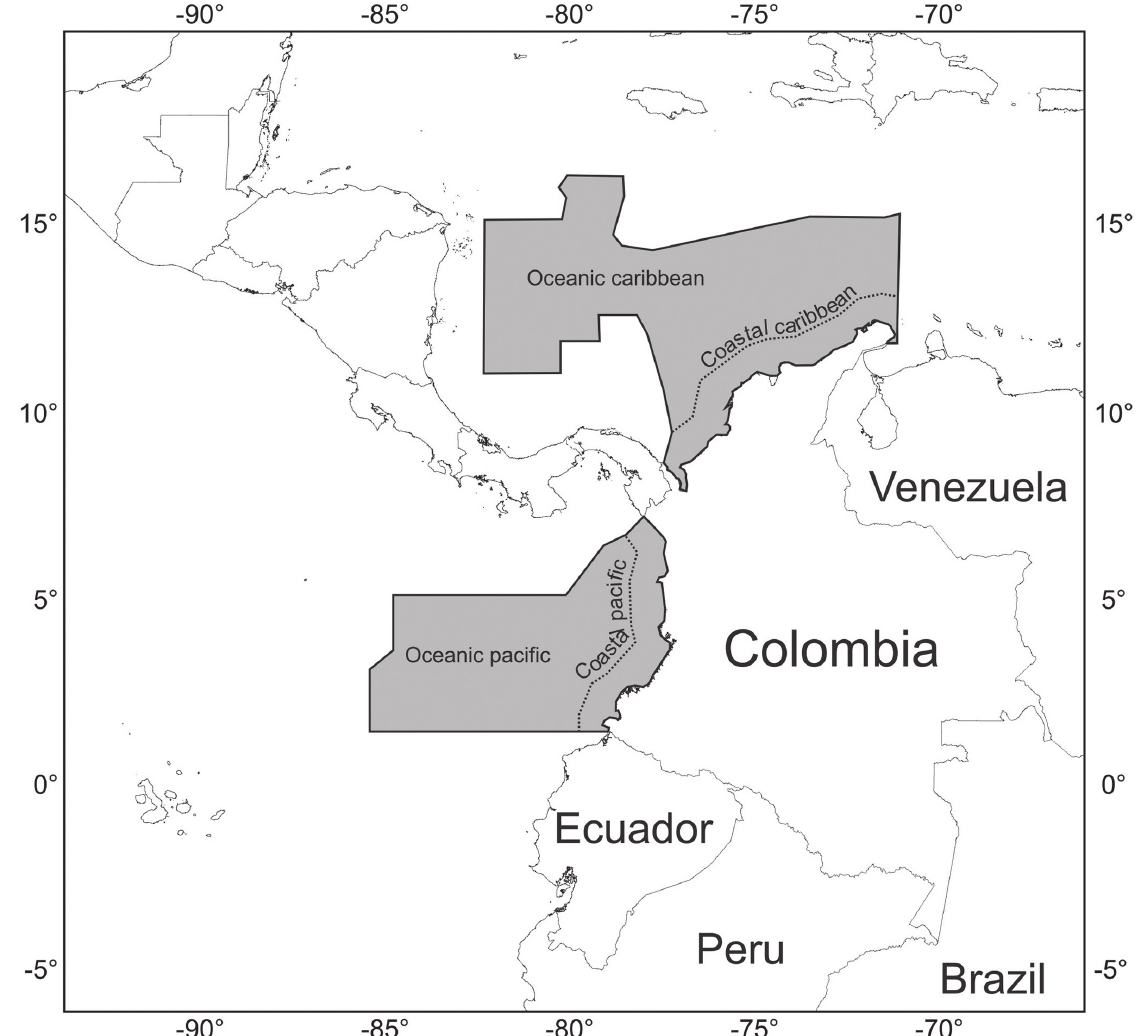
Fig. 1. Study area indicating the territorial limits of the Colombian seas. The dotted lines indicate the partitioning into the subareas (Coastal Caribbean, Oceanic Caribbean, Coastal Pacific and Oceanic Pacific) used in this study